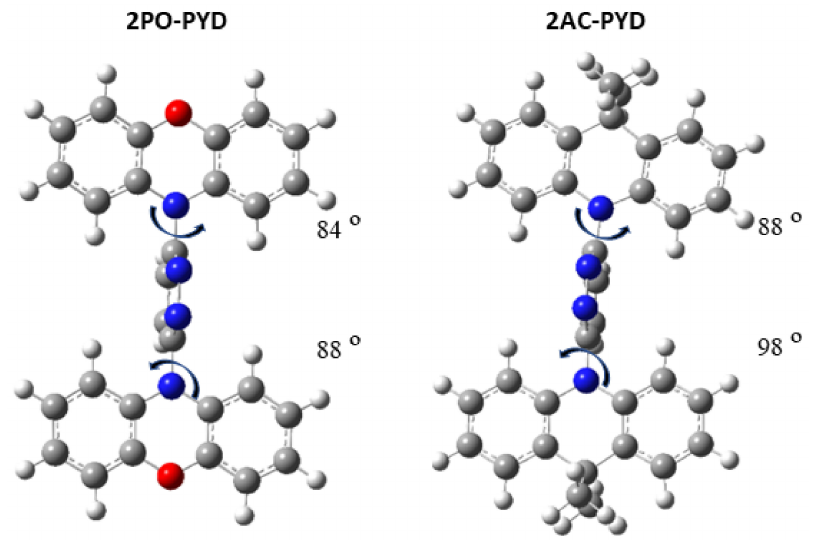
Figure 2. Optimized ground-state geometries in vacuum at the B3LYP/6-31++G level of theory of pyridazine derivatives 2PO-PYD and 2AC-PYD (grey color: carbon; blue: nitrogen; red: oxygen; white: hydrogen).